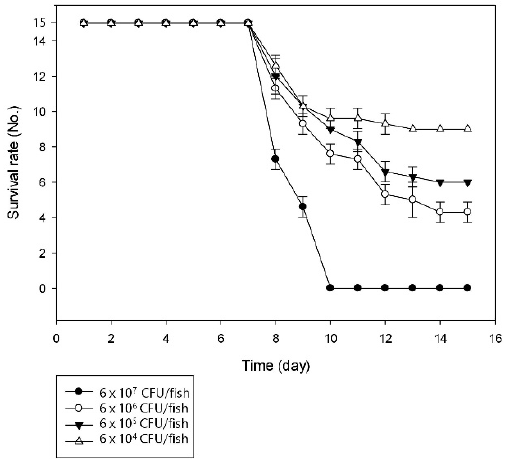
Figure 1. Challenge trial results indicating the average number of surviving fish per group at 15 days post infection.